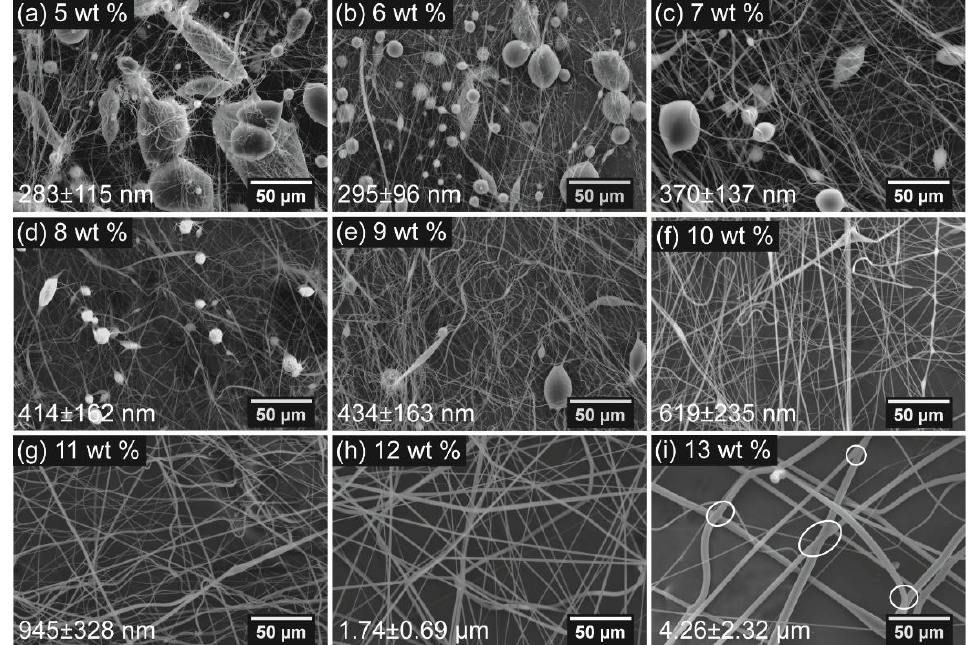
Figure 3. Scanning electron microscope images of centrifugally spun rPET fibers prepared from various polymer solution concentrations: ( a ) 5; ( b ) 6; ( c ) 7; ( d ) 8; ( e ) 9; ( f ) 10; ( g ) 11; ( h ) 12; and ( i ) 13 wt %. Centrifugal spinning condition: rotational speed, 15,000 rpm; needle inner diameter, 160 μm; collection distance, 10 cm.